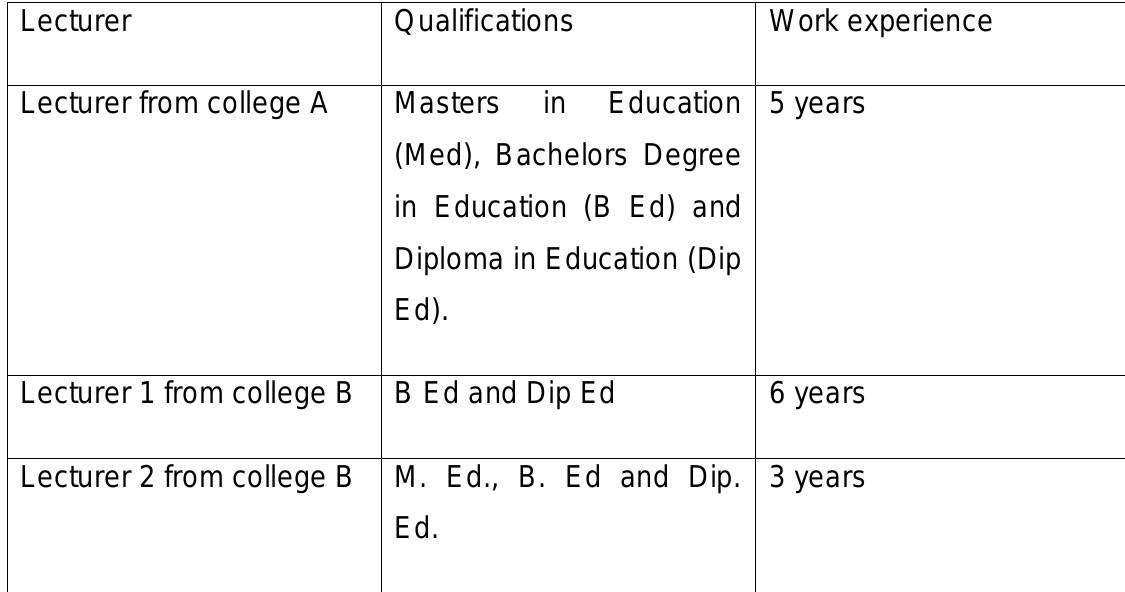
Table 4.1. PROFILES OF